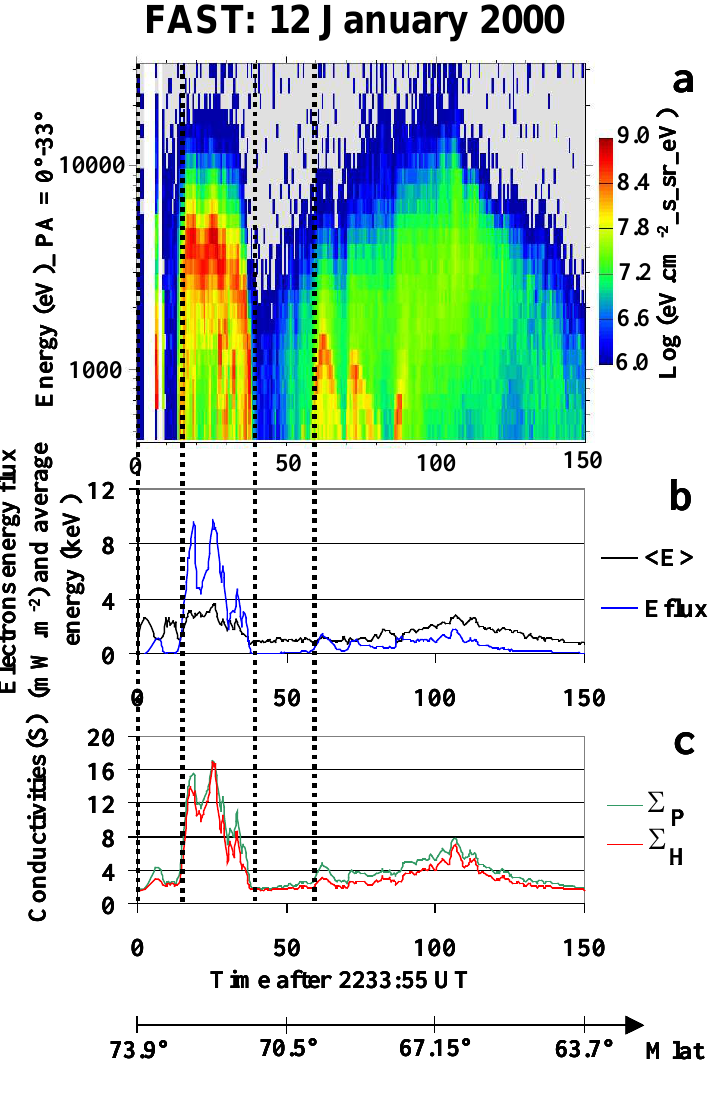
Fig. 7. Electron precipitation mea- sured by FAST, between 22:33:55 and 22:36:25 UT. (a) Energy-flux diagram of the downgoing electrons, for the range 400eV–30keV. (b) Energy flux and average energy. (c) Pedersen and Hall ionospheric conductances. The po- sition of the three field-aligned current sheets deduced from FAST magnetic perturbations is superimposed (dotted